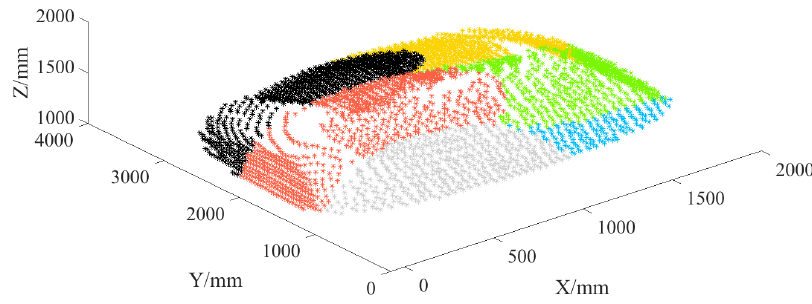
Figure 30. The painted zones of target points.